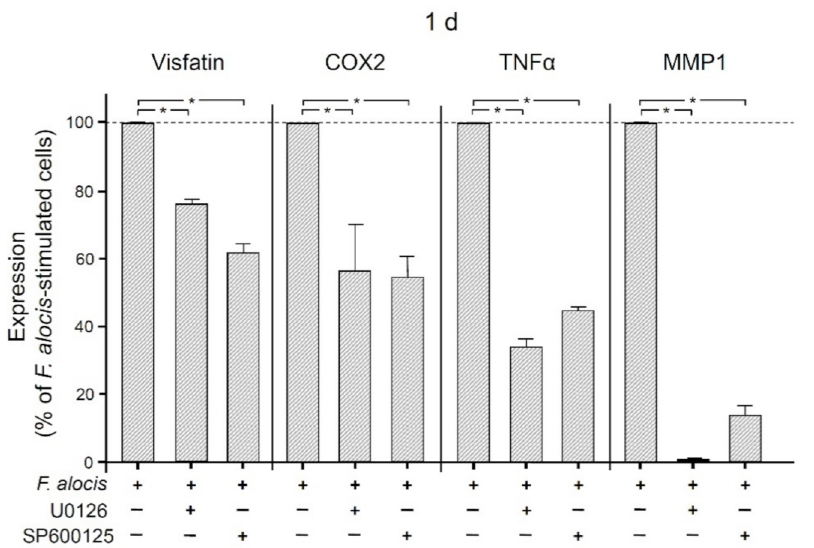
Figure 5. Expression of visfatin, COX2, TNF α , and MMP-1 in response to F. alocis (OD 660 : 0.1) in the presence and absence of an inhibitor against MEK1/2 (U0126; 10 µ M) or JNK (SP600125; 10 µ M) in human macrophages after 1 d, analyzed by real-time PCR. Mean ± SEM, n = 3/group. * significant ( p < 0.05) difference between groups.